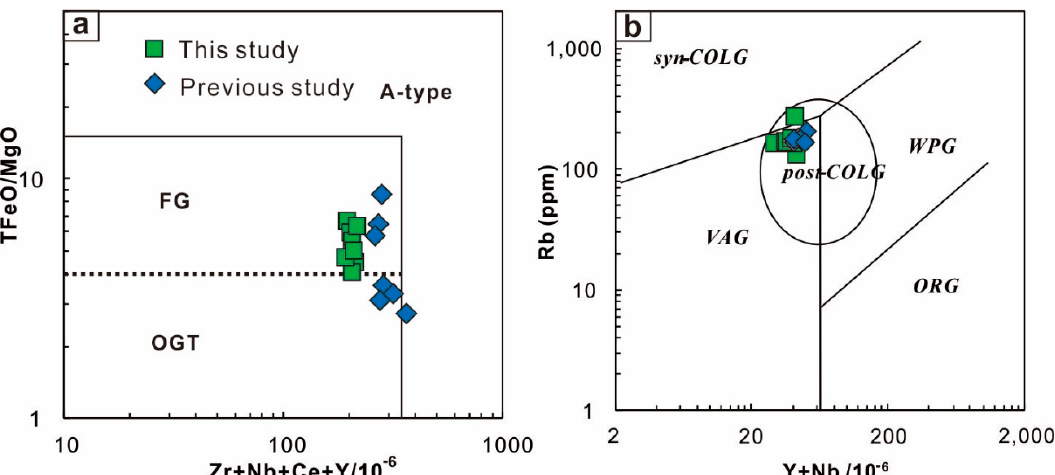
Figure 9. Geochemical discrimination diagrams of TFeO/MgO versus Zr + Nb + Ce + Y ( a ) [100] and Rb versus Y + Nb ( b ) [101] of the Banzhusi granite porphyry. A previous study was conducted by